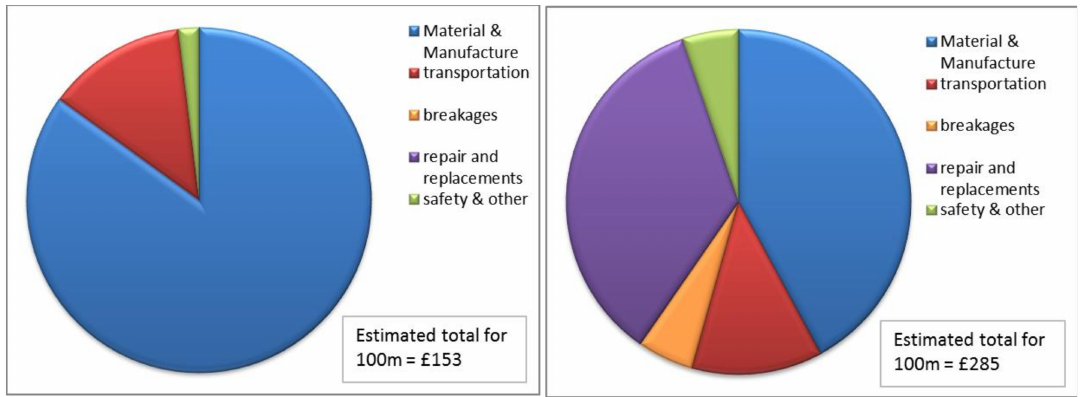
Figure 9. Cost analysis for 100 m edging curb units, re-formative polymer composite vs concrete (this